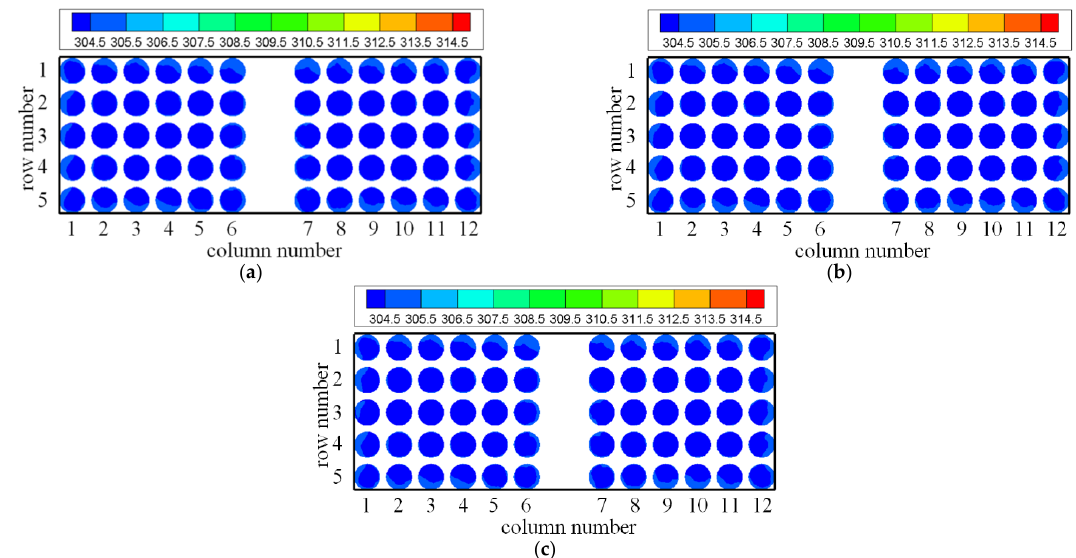
Figure 5. Temperature distribution of inlet air of the fans under windless condition: ( a ) Design case; ( b ) Str-1 case; ( c ) Str-2 case.